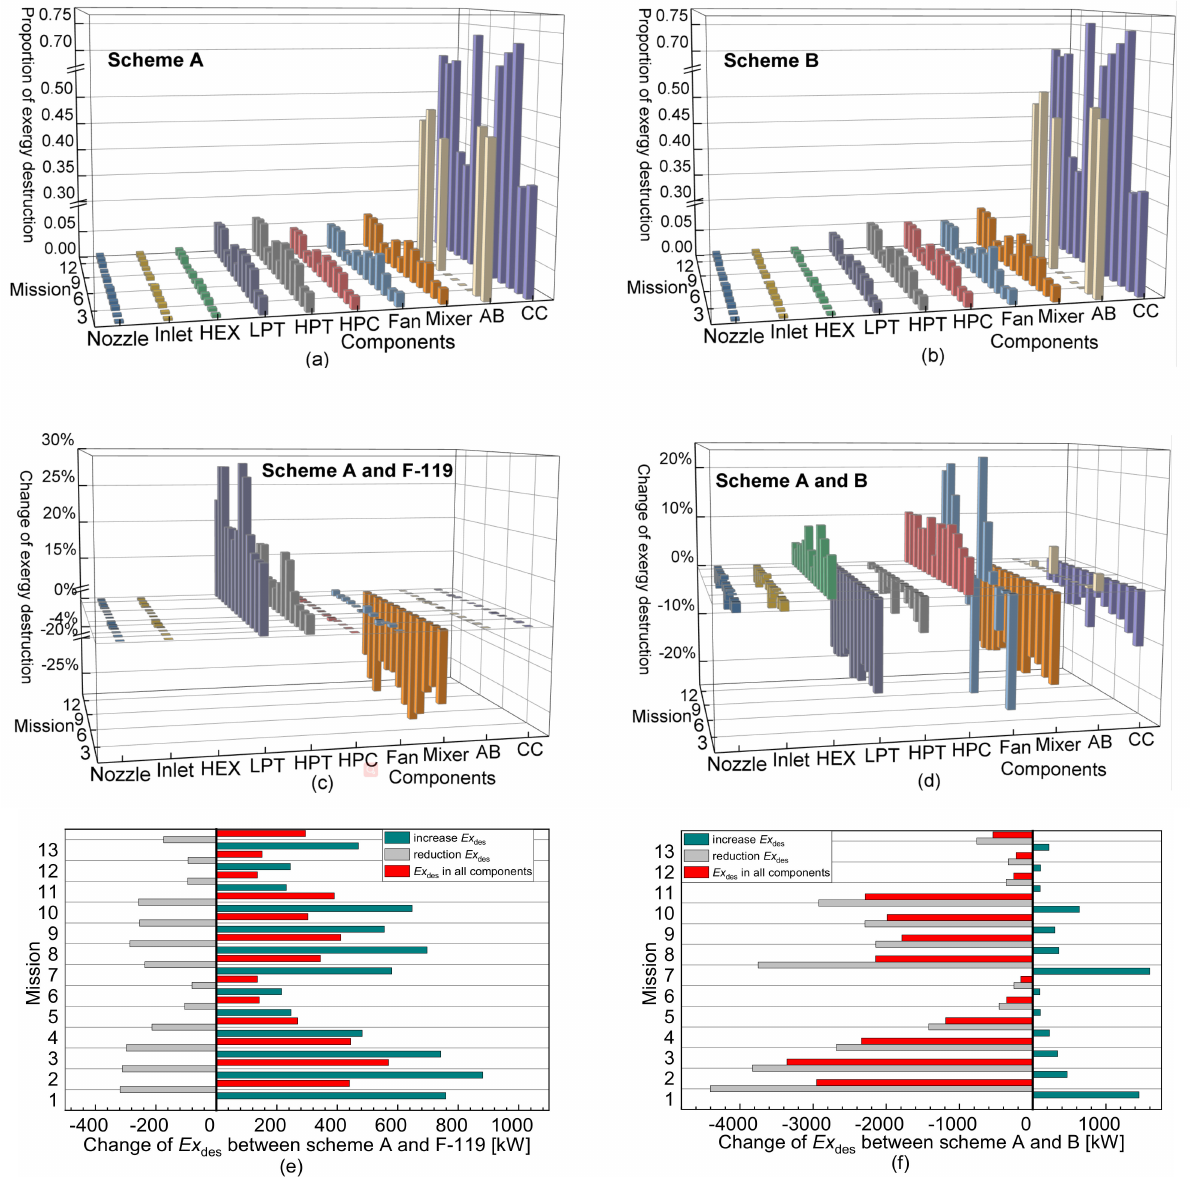
Figure 10. ( a ) The distribution of exergy destruction in Scheme A; ( b ) The distribution of exergy destruction in Scheme B; ( c ) The comparison of local exergy destruction between F-119 and Scheme A; ( d ) The comparison of local exergy destruction between Schemes A and B; ( e ) The comparison of total exergy destruction between F-119 and Scheme A; ( f ) The comparison of total exergy destruction between Schemes A and